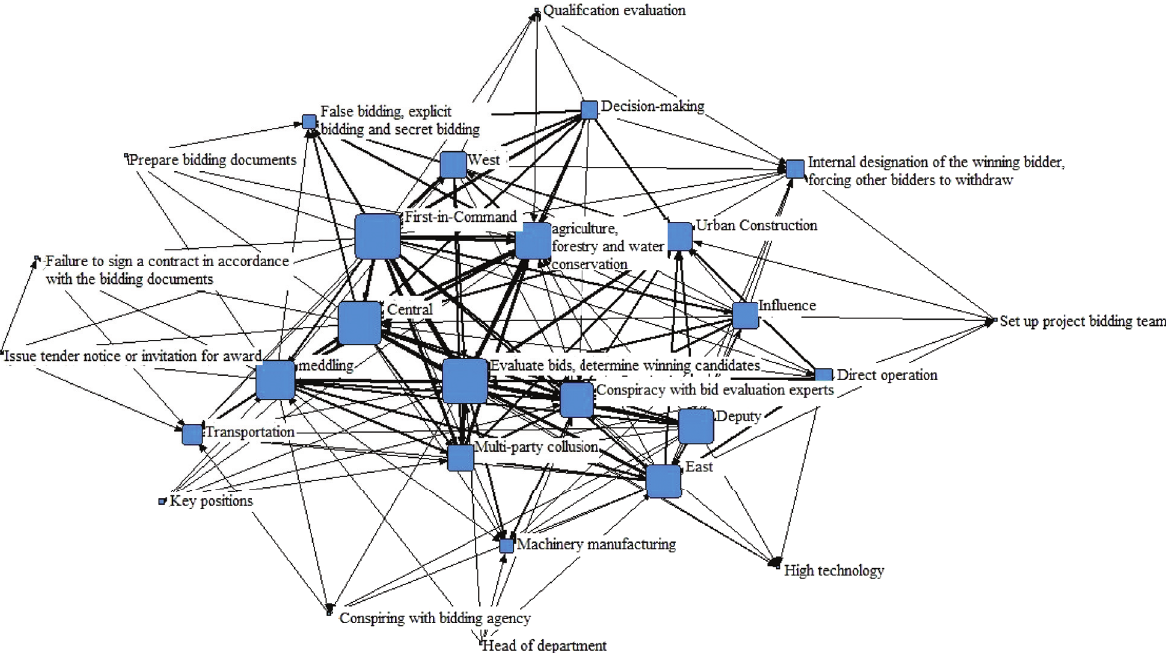
Figure 6: Co-occurrence network of cooperative collusion variables. Table 4: Centrality of cooperative collusion